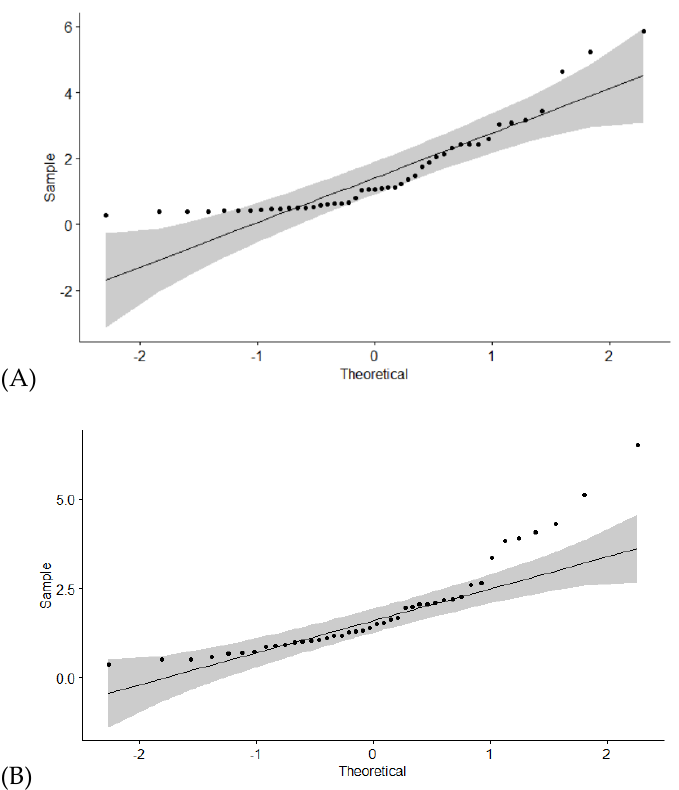
Figure 6. Q − Q plots used to check normal distribution of the measured uniform corrosion rates in ( A ) pH 12.5 with 1 M Cl − ; and ( B ) pH 13.5 with 1 M Cl − . ( A ) pH 12.5 with 1 M Cl − ; and ( B ) pH 13.5 with 1 M Cl −